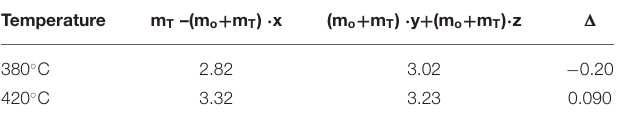
TABLE 7 | Balancing results of mass of tetralin in oil product obtained by liquefaction (Assuming: under liquefaction conditions, the tetralin is completely in the liquid state and its mass is denoted as m T , while the mass of oil product from coal transformation is denoted as m o ). Temperature